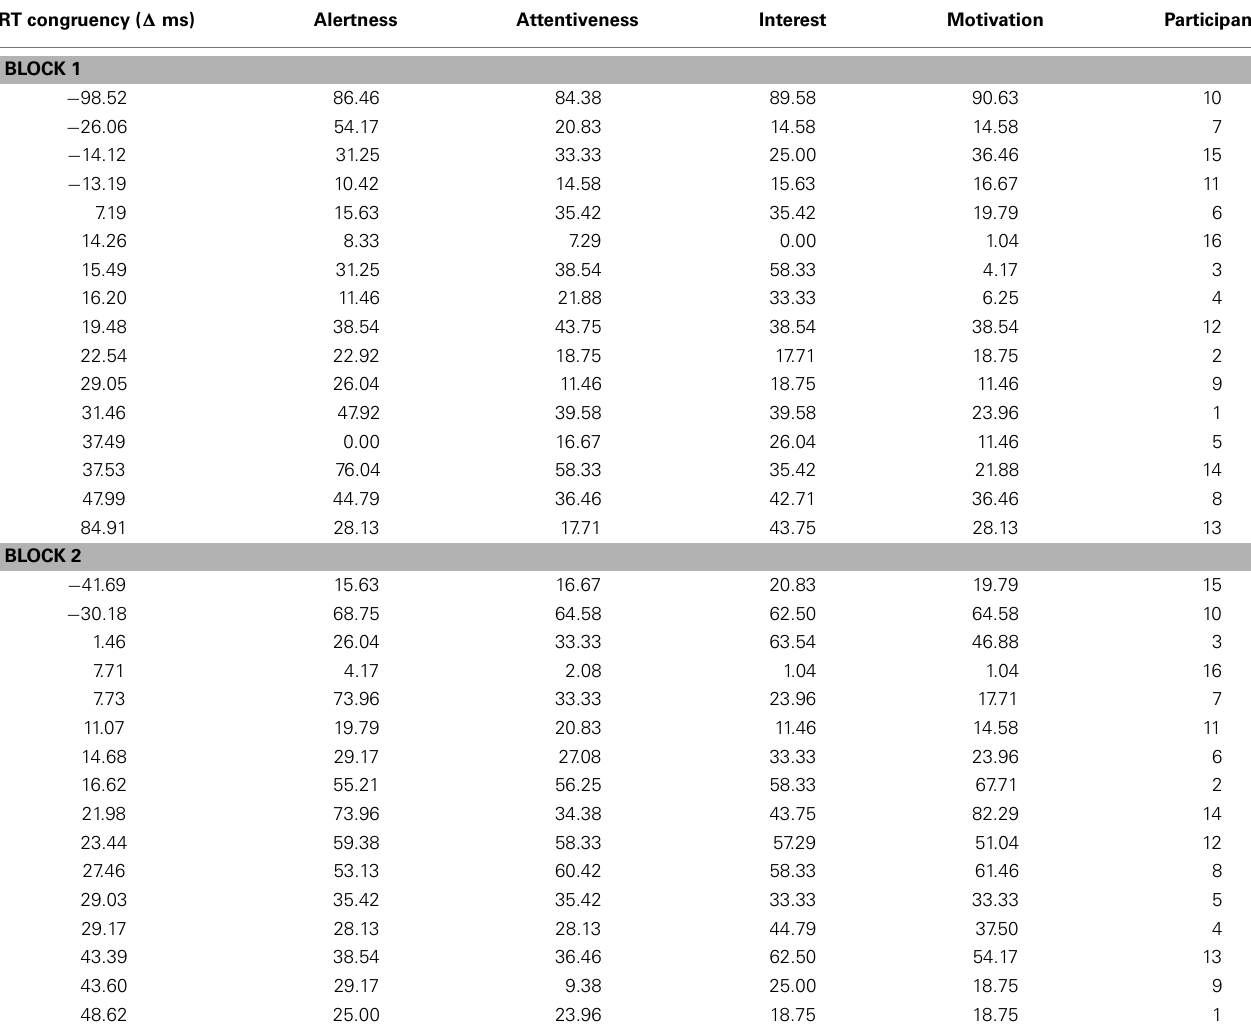
Table 3 | Individual congruency effects in Block 1 and Block 2 of Experiment 2, as well as individual scores on each of the items on theVAS scale administered after Block 2 and after Block 3; sorted according to increasing congruency effects.